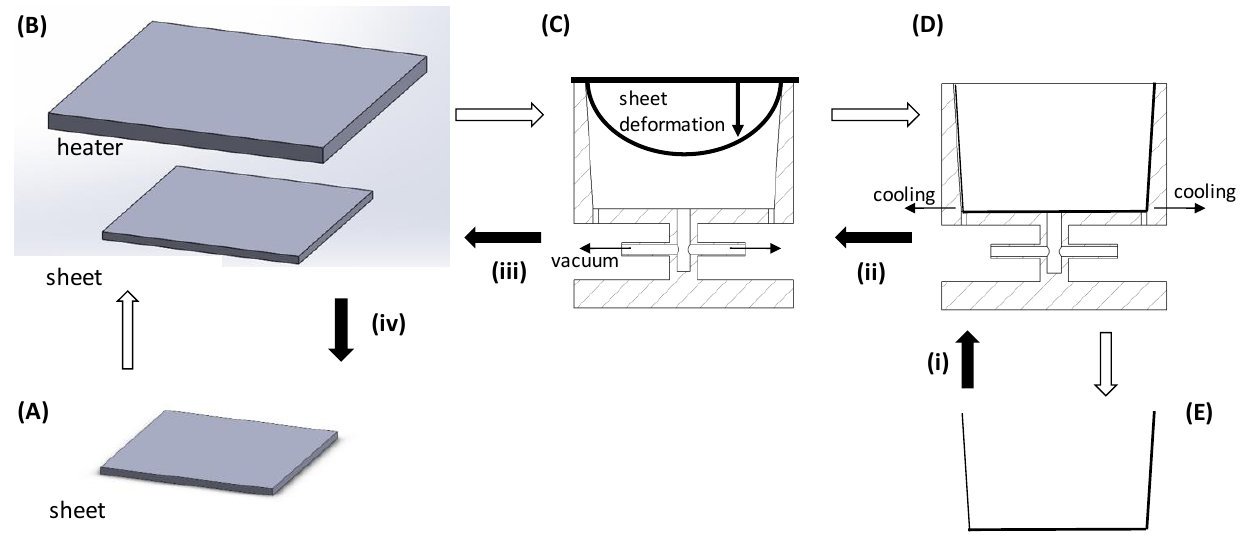
Figure 1. Thermoforming process and optimization. Thermoforming phases: ( A ) sheet; ( B ) heating; ( C ) shaping; ( D ) cooling; ( E ) final part. Optimization steps: ( i ) part properties; ( ii ) cooling effects; ( iii ) final part thickness distribution; ( iv ) sheet thickness distribution.